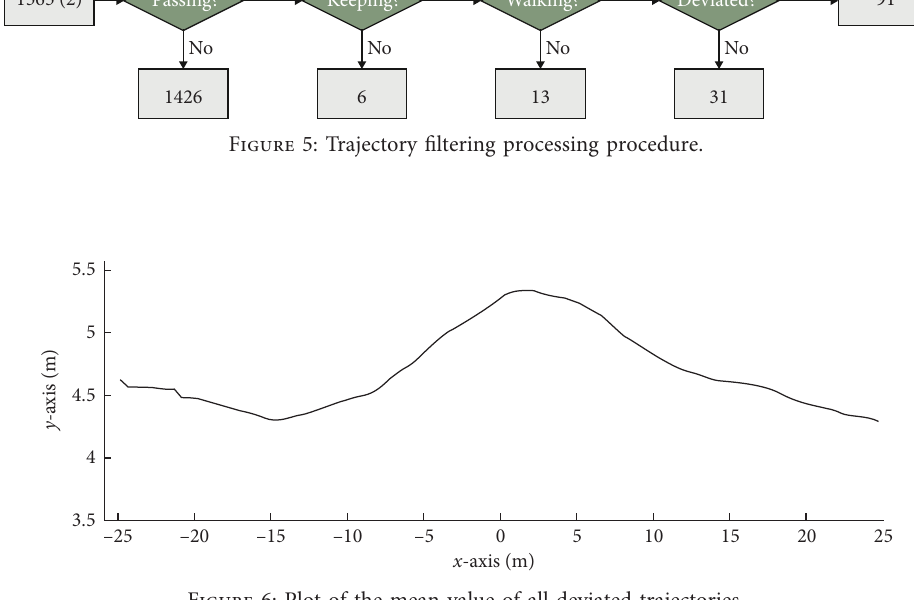
Figure 6: Plot of the mean value of all deviated trajectories.